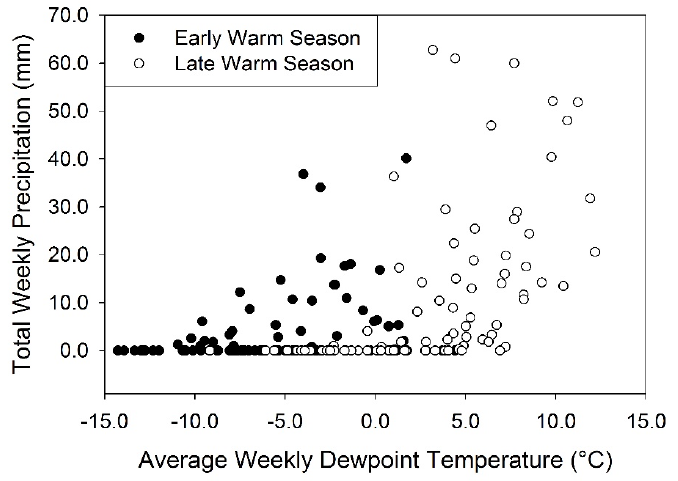
Figure 5. Total weekly precipitation plotted against average weekly dewpoint temperature for early and late warm season at our study site. The larger precipitation events occurred during the late warm season as dewpoint temperature increased.